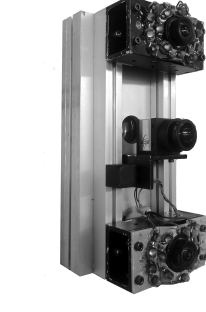
Figure 3. Sensor setup used throughout our experiments: Near-infrared sensitive camera equipped with wide-angle lens, bandbass filter, and 16 high-power IR LEDs ( left ) and stereo camera unit formed by two identical camera units ( right ). The additional color camera in the center of the stereo rig is not used by the tracking algorithm but serves purely for visualization purposes.